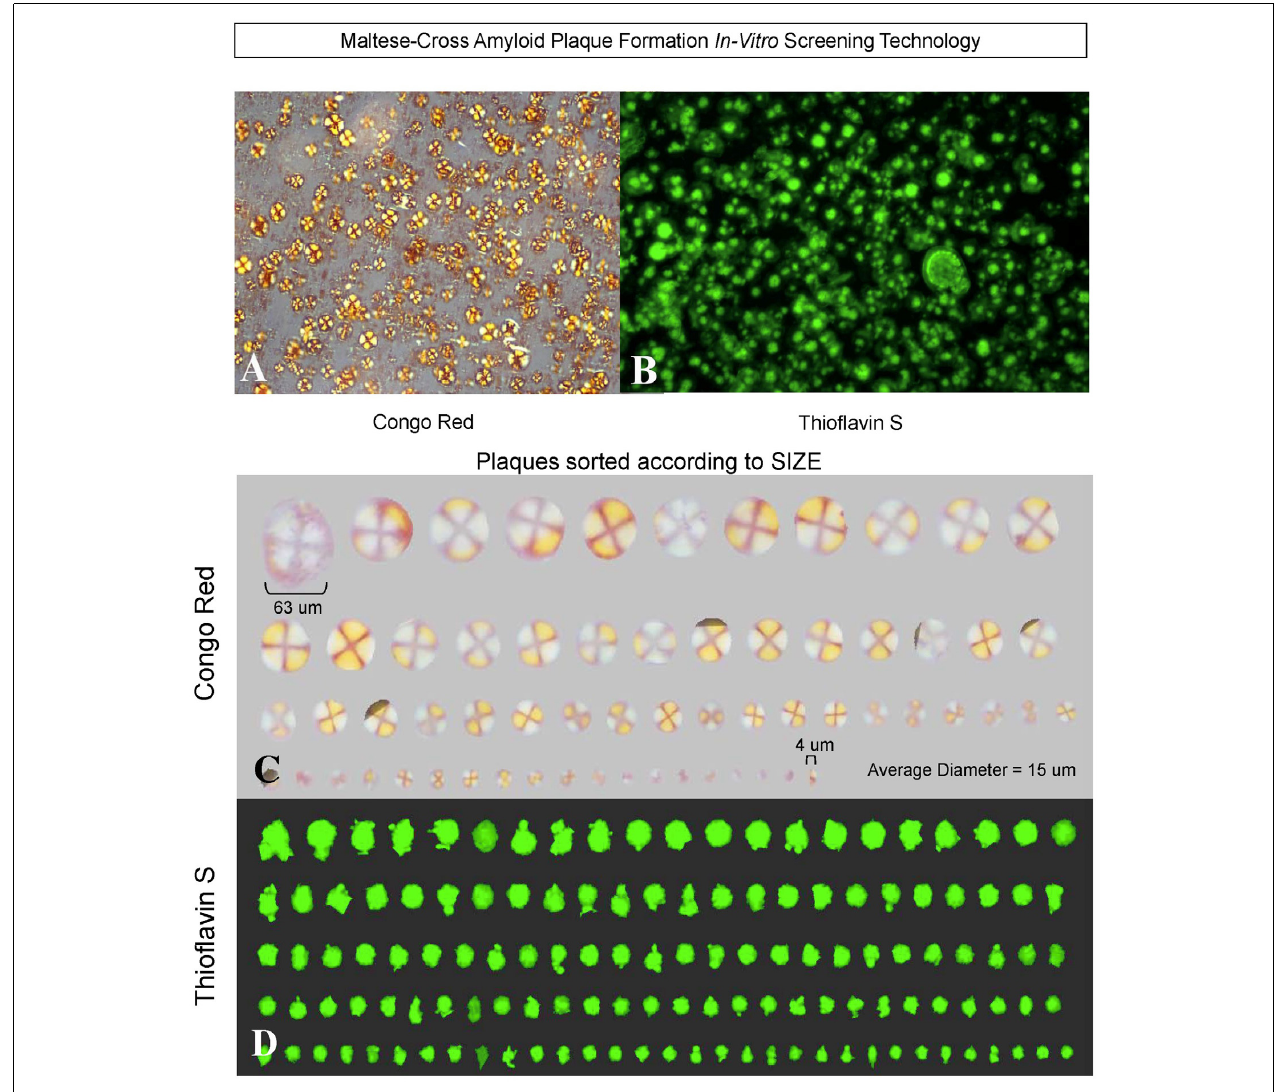
FIGURE 8 | Heparan sulfate GAGs induce A β 1–40 (but not A β 1–42) to form spherical congophilic and thioflavin S maltese-cross amyloid plaques identical to those seen in AD brain. Heparan sulfate GAGs + A β 1–40 (but not A β 1–42) at 1:8 molar ratio (i.e., 50 µ g A β 1–40 in 100 µ l of distilled water with 400 µ g of heparan sulfate) spontaneously form (within minutes) spherical congophilic maltese-cross amyloid plaques (A) and Thioflavin S plaques (B) identical to those observed in AD brain. Spherical maltese-cross amyloid cores were not observed with A β 1–40 or A β 1–42 alone. (C) Congo red plaques formed by A β 1–40 + heparan sulfate GAGs sorted according to size, ranging from 4 µ m up to 63 µ m, with an average diameter of 15 µ m. Note the red-green birefringence of the amyloid cores as viewed under polarized light. Rotation of the polarizer changes the red color to green, and the green color to red (i.e., red/green birefringence). This also occurs identically in the human AD brain following staining with Congo red and viewing brain sections under polarized light. (D) Thioflavin S fluorescence demonstrating the various sizes of amyloid cores formed after incubation of A β 1–40 + heparan sulfate GAGs (Castillo and Snow,